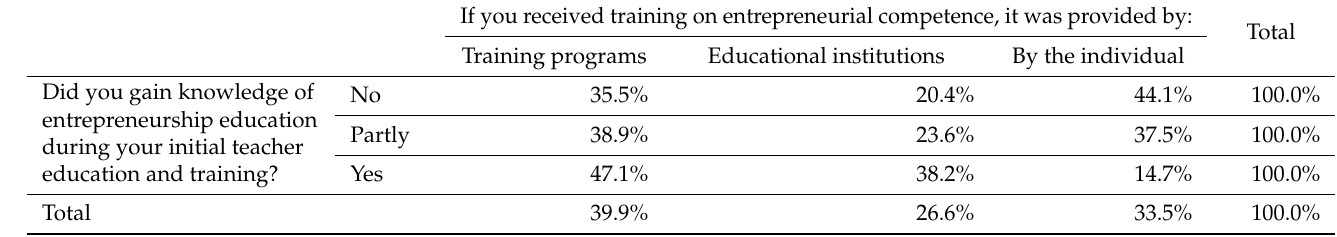
Table 2. Crosstabulation of (Q6) and (Q8).